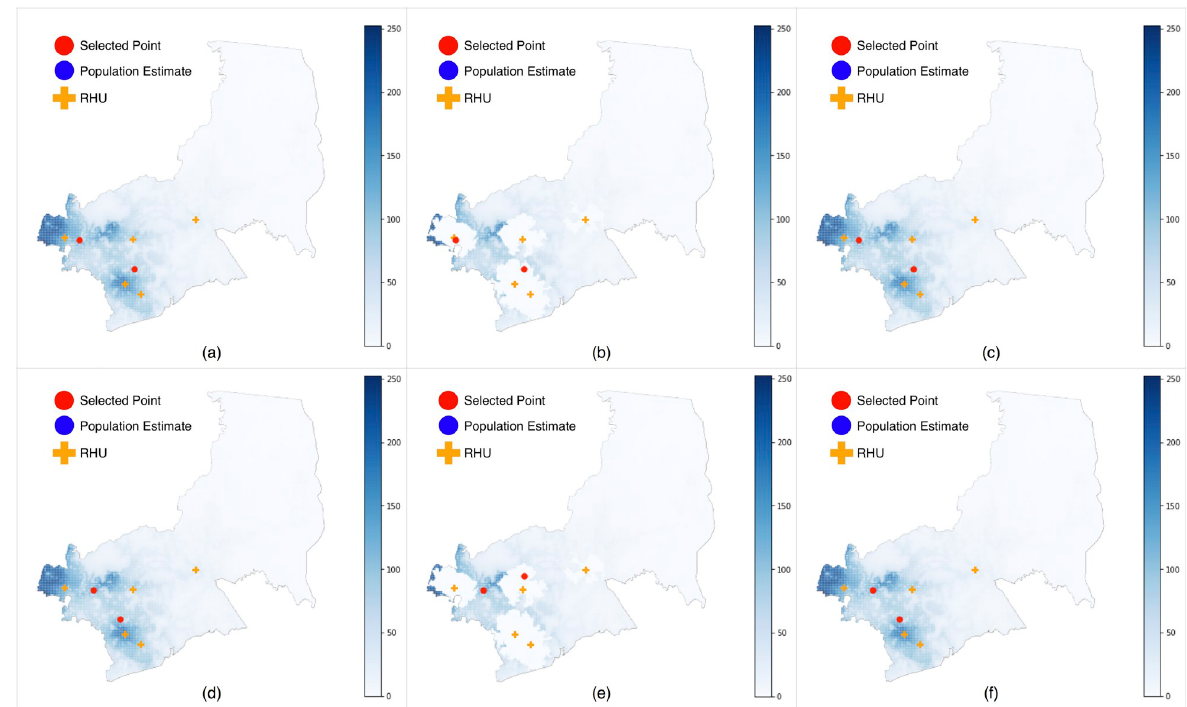
Fig 3. Optimized locations for 1 RHU in Antipolo City. (a) Metric 1, No demand adjustment, Sumulong Hwy, Brgy. Mambugan (Near Mambugan Brgy. Hall) & Buliran Rd, Brgy. San Luis (Near Philippine International College), (b) Metric 1, Method A, Sumulong Hwy, Brgy. Mambugan (Near Villa Cecilia Subdivision) & Buliran Rd, Brgy. San Luis, (Near Philippine International College), (c) Metric 1, Method B, Sumulong Hwy, Brgy. Mambugan (Near Mambugan Brgy. Hall) & Buliran Rd, Brgy. San Luis (Near Philippine International College), (d) Metric 2, No demand adjustment, Sumulong Hwy, Brgy. Santa Cruz (Near Town and Country Estates) & Magsaysay Ave, Brgy. Dela Paz (Near Robinsons Place Antipolo), (e) Metric 1, Method A, Sumulong Hwy, Brgy. Santa Cruz (Near Town and Country Estates) & Sun Valley W Drive, Brgy. Inarawan (Near Forest Hills Golf & Country Club), (f) Metric 1, Method B, Sumulong Hwy, Brgy. Santa Cruz (Near Town and Country Estates) & Magsaysay Ave, Brgy. Dela Paz (Near Robinsons Place